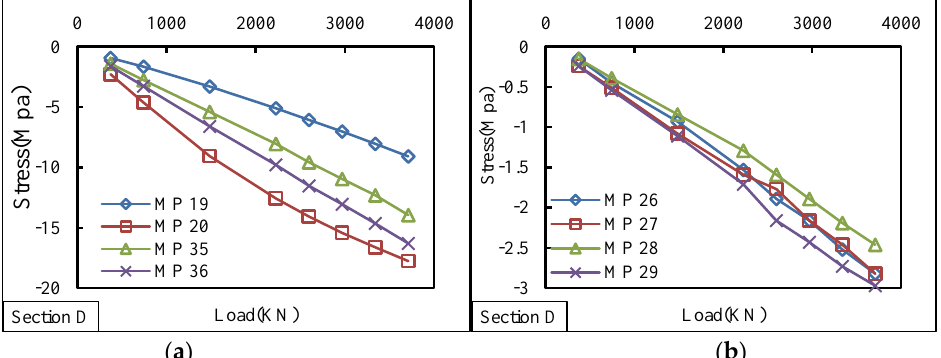
Figure 13. The relationship between load and stress of the concrete at Section D-D on the bottom slab specimen: ( a ) the top surface of the concrete; and ( b ) the bottom surface of the concrete. MP, measuring point.